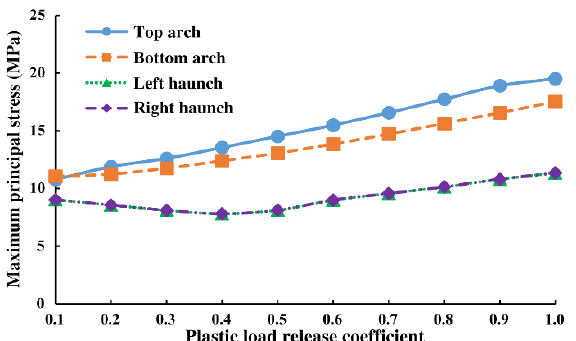
Figure 8. Surrounding rock stress variation with plastic load release coefficient of type V surround- ing rock.